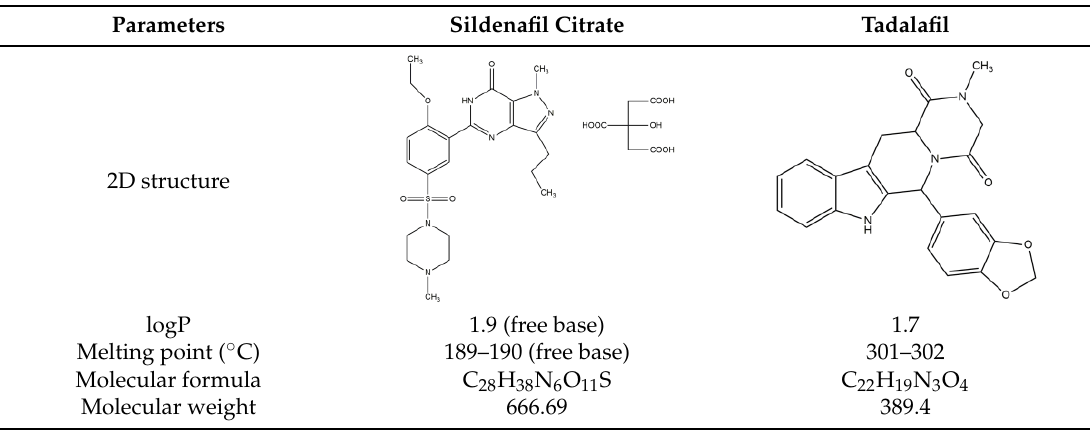
Figure 1. Transmission electron microscopy (TEM) micrographs of empty nanoliposomes ( A ); SIL- nanoliposomes ( B ) and TAD-nanoliposomes ( C ). Bar: 200 nm. Table 2. Physicochemical properties of sildenafil citrate and tadalafil used for encapsulation within nanoliposomes.